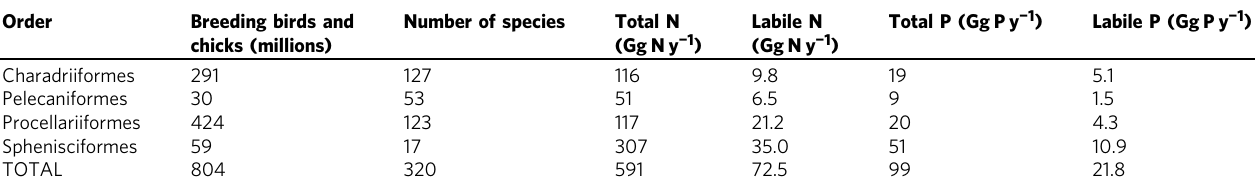
Table 1 Estimated total and labile forms of excreted N and P arranged by seabird order Order Breeding birds and chicks